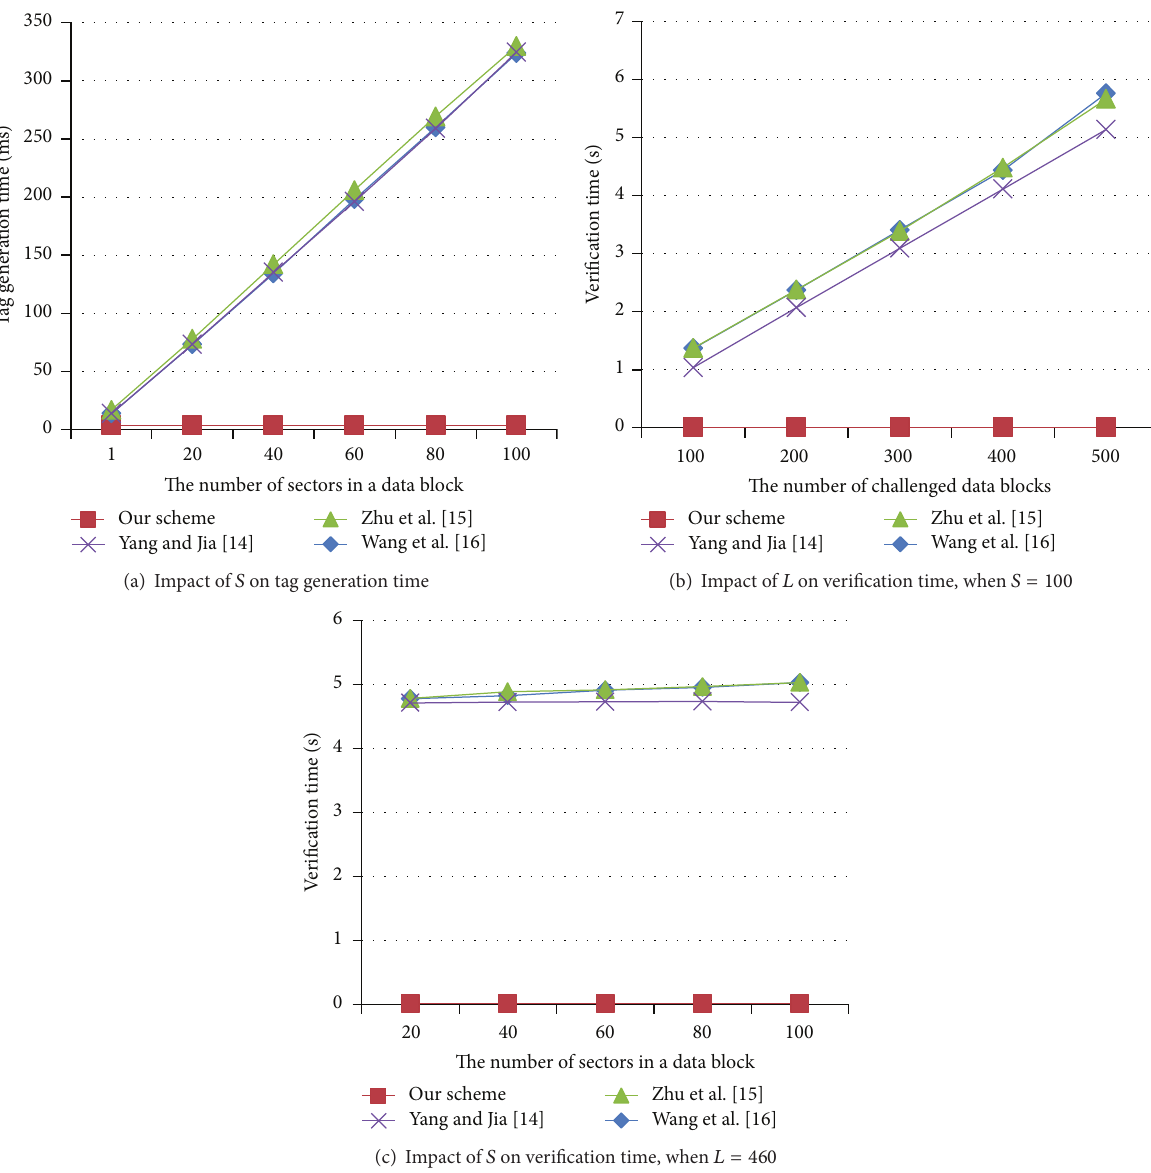
Figure 7: Experimental